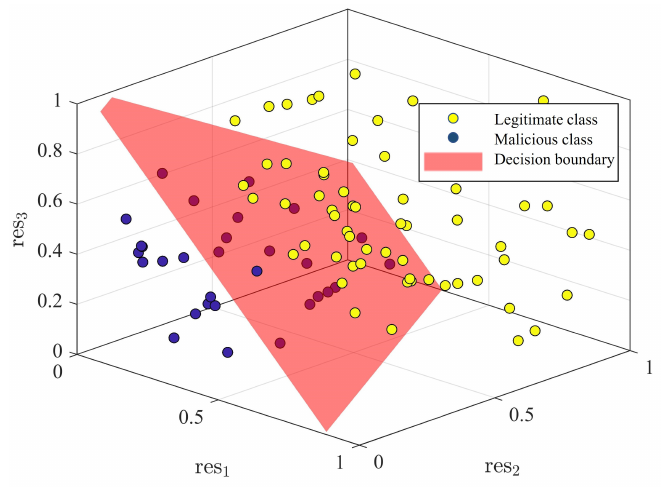
Figure 6. Decision boundary in 3D. Figure 7 analyzes the accuracy of the proposed FL training algorithm in two